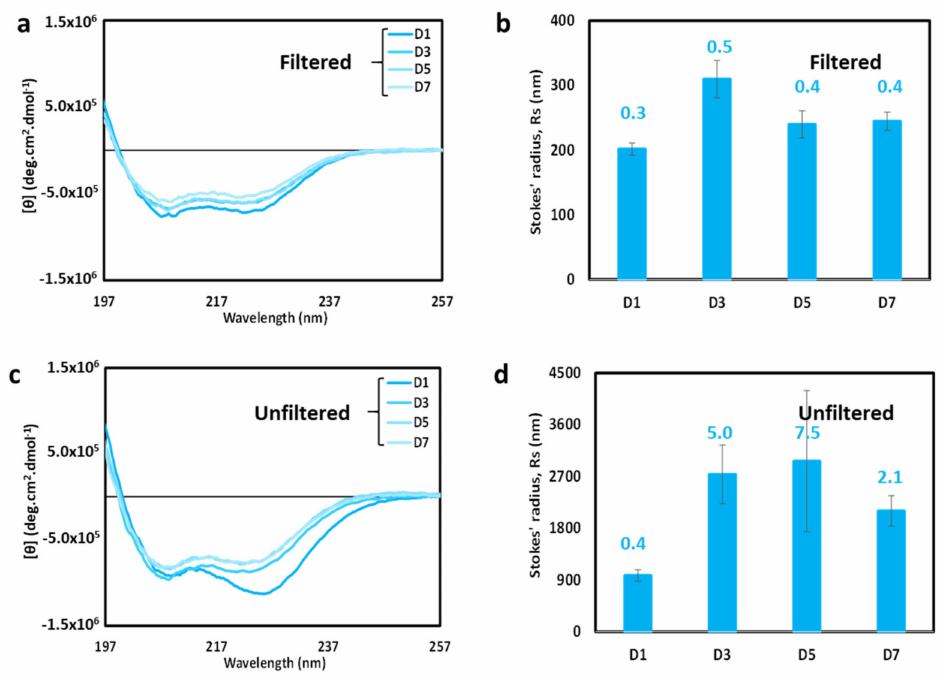
Figure 7. Time-dependence of cl-Par-4 in the presence of 50 mM MgSO 4 . ( a ) Overlay of CD spectra obtained over a seven-day time course. Sample was filtered on day 1 prior to the first spectrum. ( b ) DLS analysis of sample from panel ( a ). ( c ) Overlay of CD spectra obtained over a seven-day time course. Sample was NOT filtered. ( d ) DLS analysis of sample from panel ( c ). In panels ( b ) and ( d ), error bars represent the standard deviation in Stokes’ radii from multiple runs, and the number above each bar represents the average polydispersity value for these